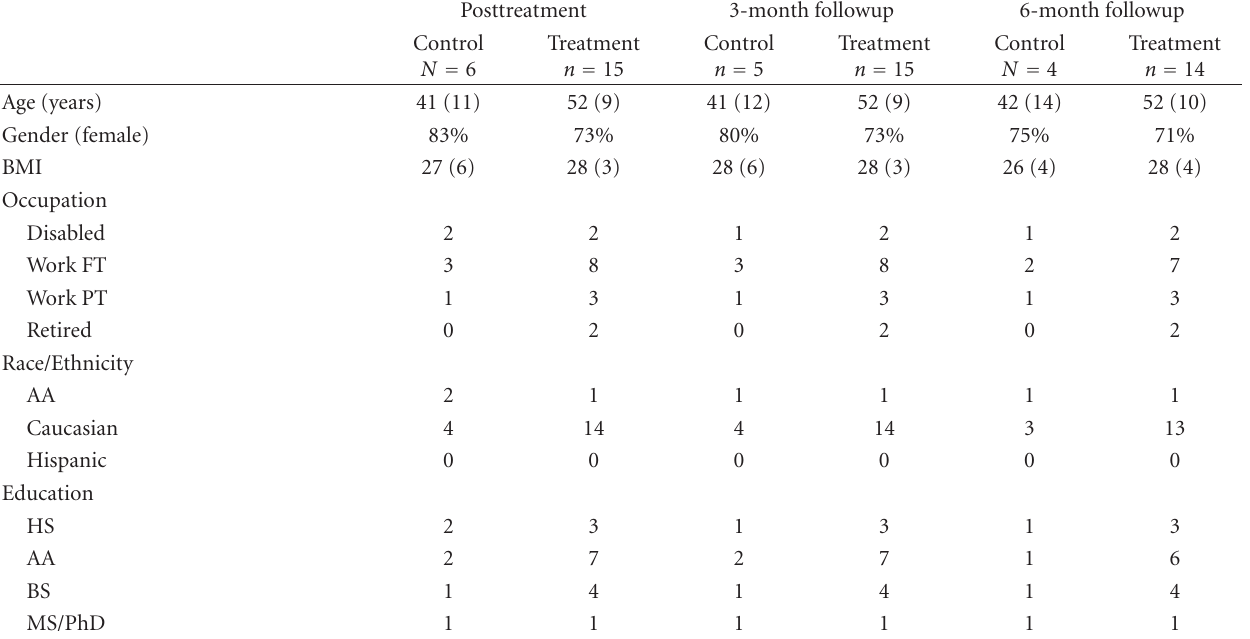
Table 1: Sample characteristics.